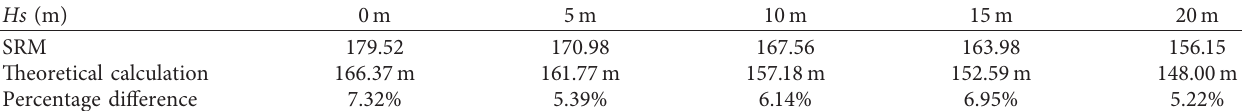
Table 8: Calculation results of limit equilibrium height of vertical rock wall.